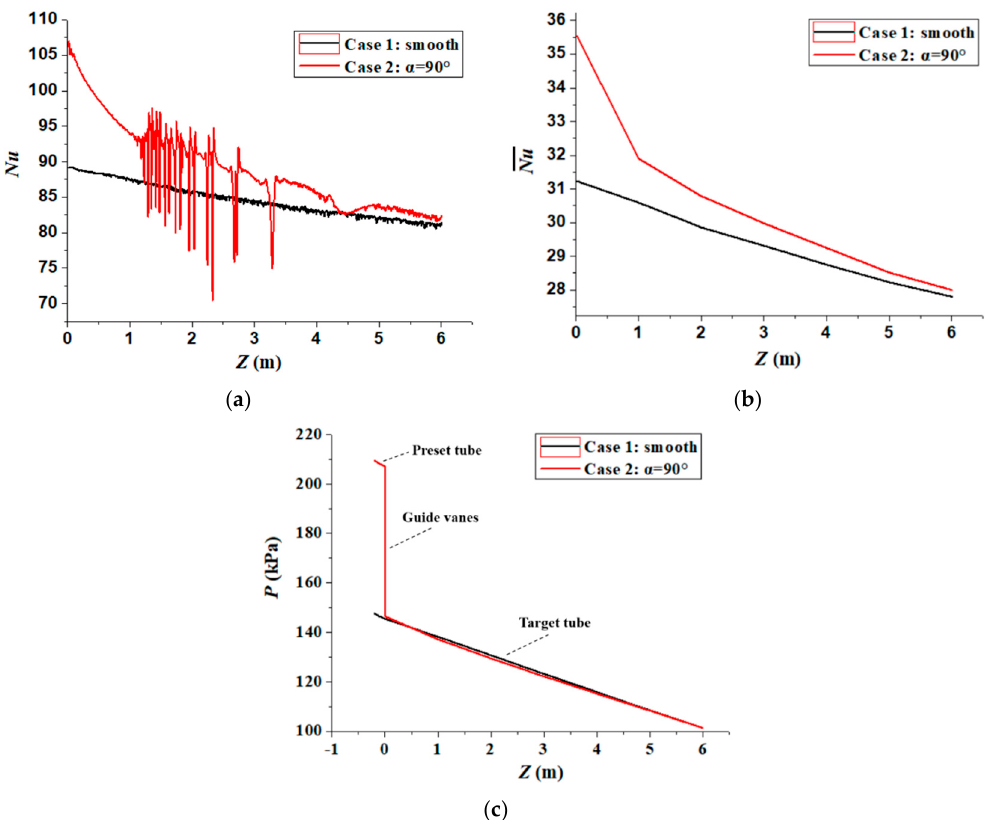
Figure 10. Distribution of Nu and statistic pressure in the smooth tube and the tube with guide vanes with α = 90°: ( a ) local Nu on Line 2; ( b ) peripherally averaged Nu along the tube; ( c ) average cross-sectional statistic pressure along the tube.